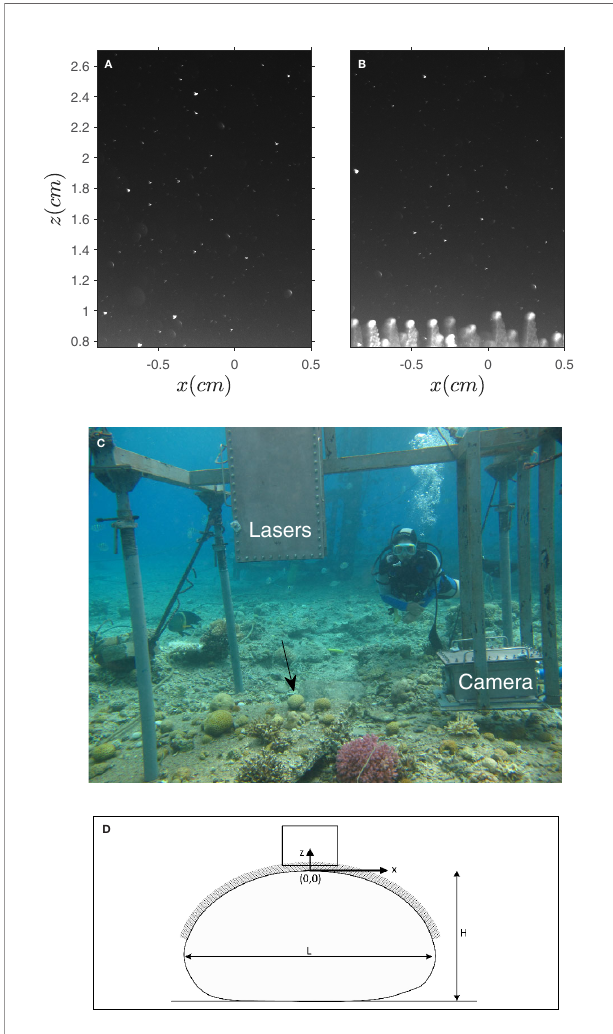
FIGURE 2 | (A, B) PIV image samples when the tentacles were contracted and extended. (C) A picture of the underwater PIV system (UPIV) with the fi rst D . favus coral (Coral I) marked by a black arrow. (D) A schematic drawing of the coral, the x-z coordinate system, and the measurement rectangular